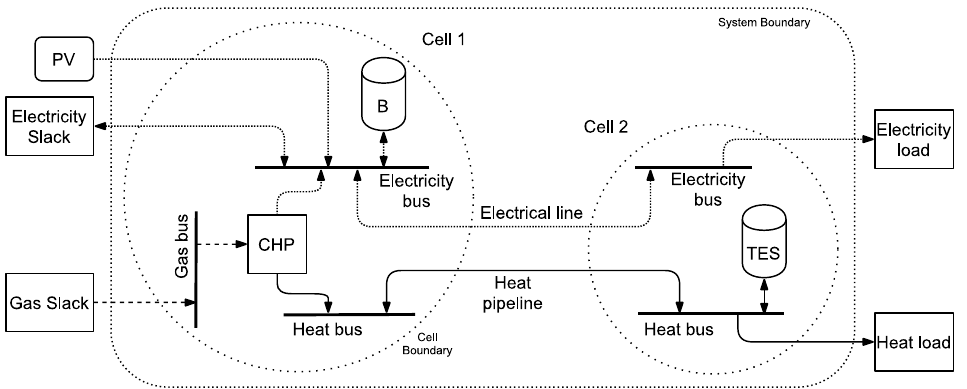
Figure 2. Example of a multi-cell open energy modelling framework (oemof) energy system model with slacks nodes, loads, RES, conversion units, storages, electrical lines and heat pipelines and busses.